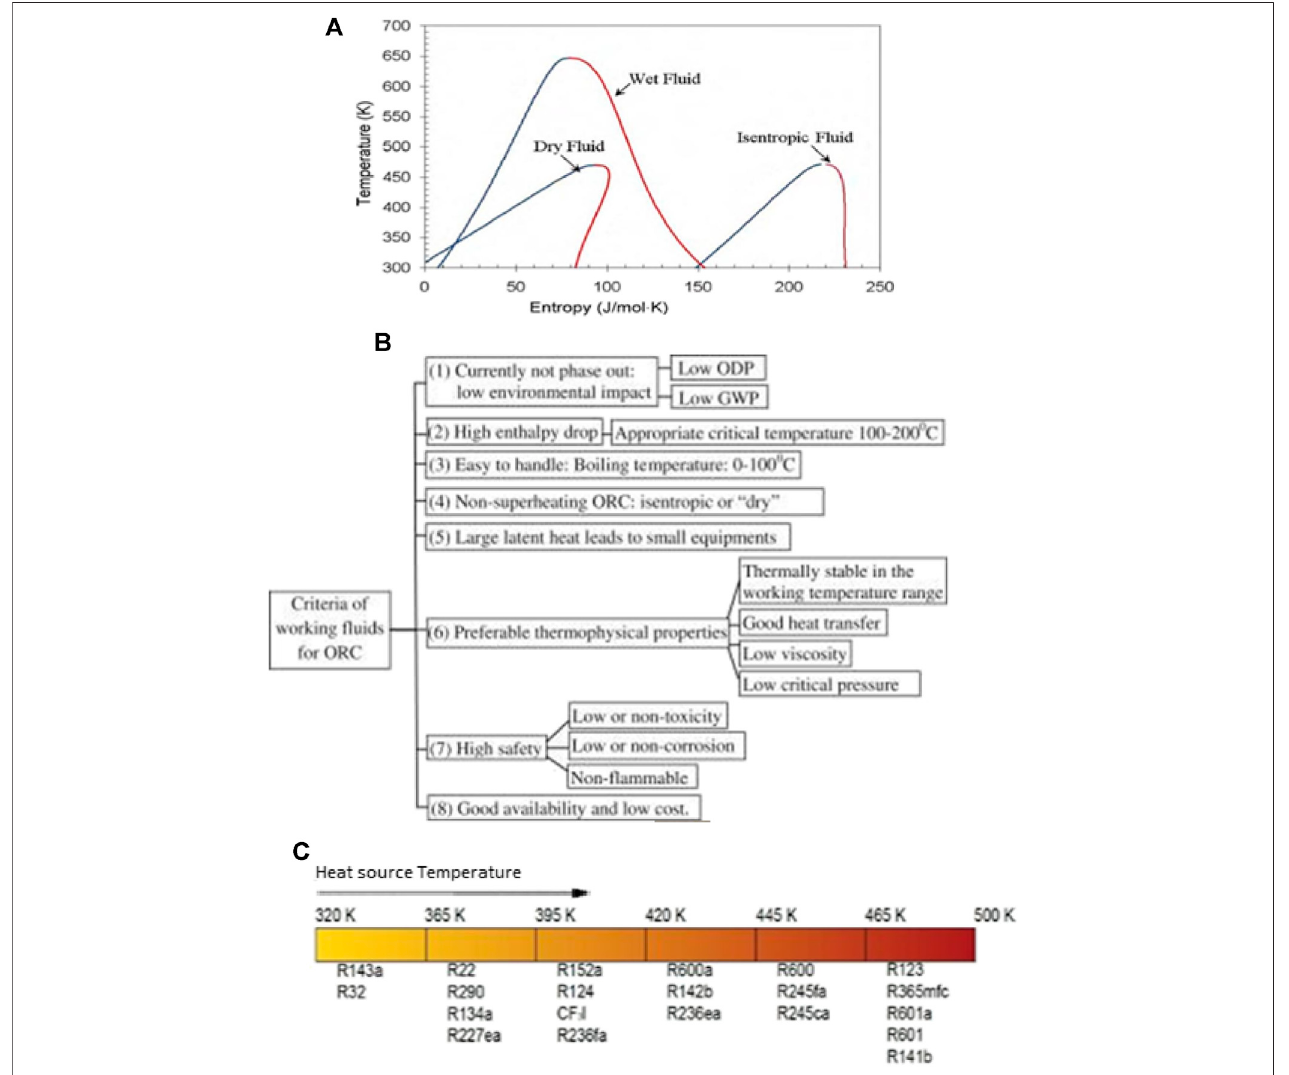
FIGURE 2 | (A) Slope of the saturation curve of an organic fl uid (Moroz et al., 2015), (B) Criteria for ORC working fl uid selection and (C) suitable organic fl uids classi fi ed by the heat source temperature (Milkov et al., 2015).